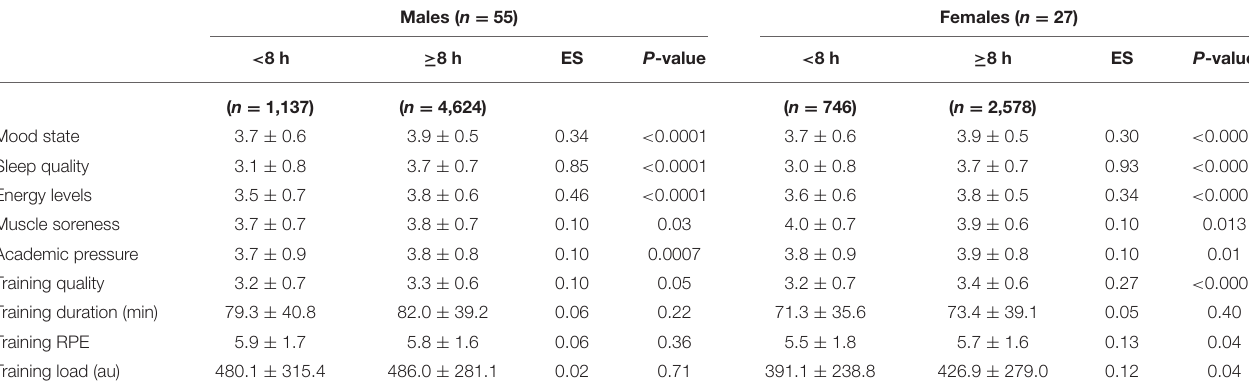
TABLE 3 | Subjective and training measures in young elite university athletes on days when they slept for < 8h compared to days when slept for 8 or more h.